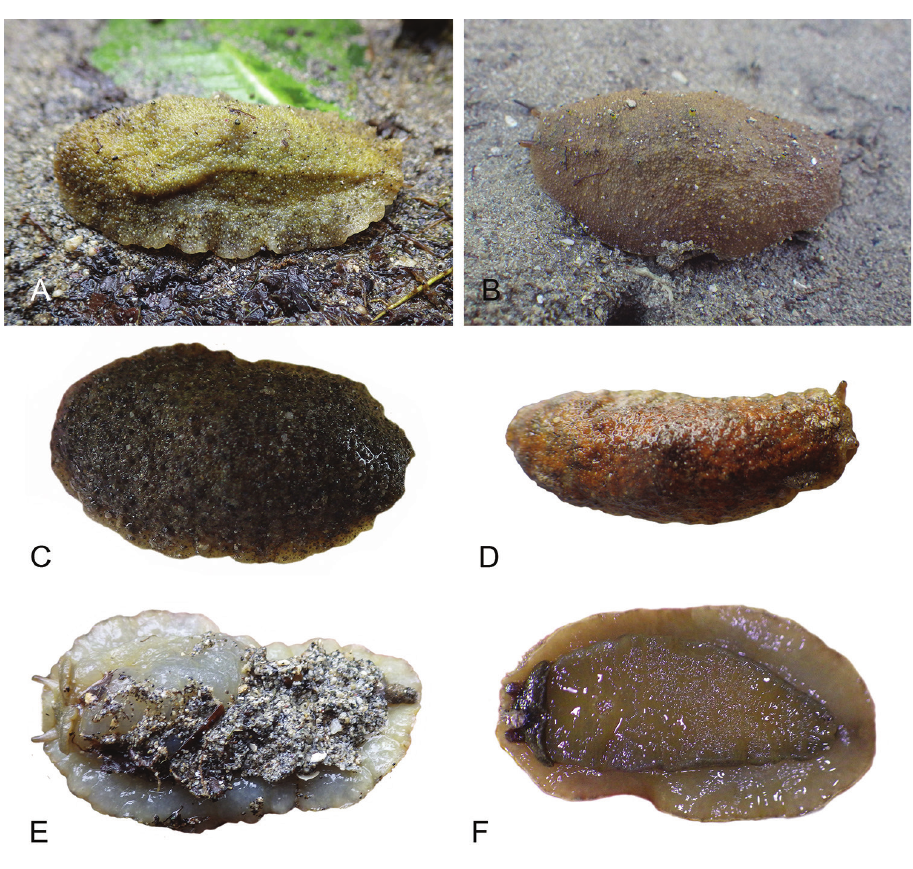
Figure 44. Live specimens, Wallaconchis graniferum , Philippines. A Dorsal view, 46 mm long [3163], Luzon (PNM 041227) B Dorsal view, 30 mm long [5902], Indonesia, Timor (UMIZ 00073) C Dorsal view, 28 mm long [3636], Bohol (PNM 041228) D Dorsal view, 26 mm long [3635], Bohol (PNM 041228) E Ventral view, same as A, F Ventral view, same as